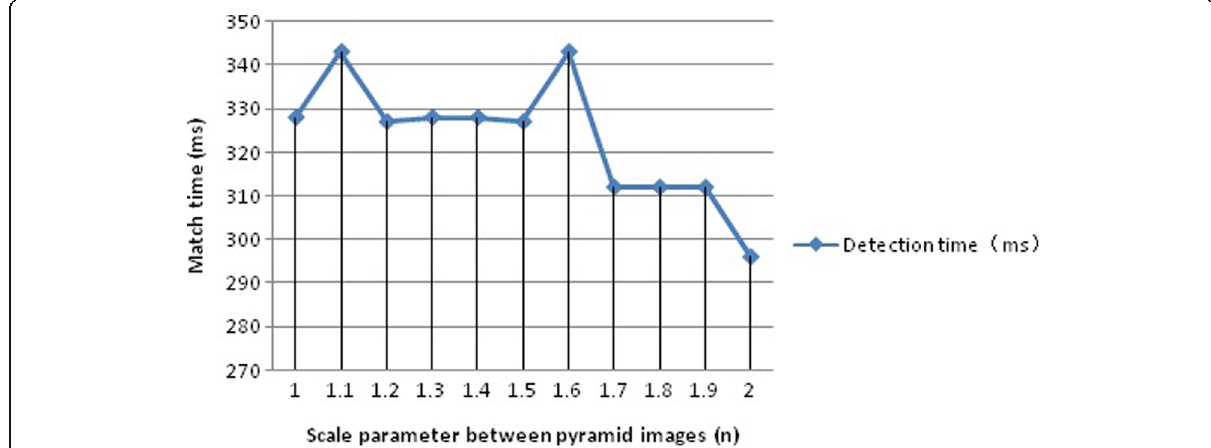
Fig. 5 Relationship between scale parameter variation and matching time between pyramid images